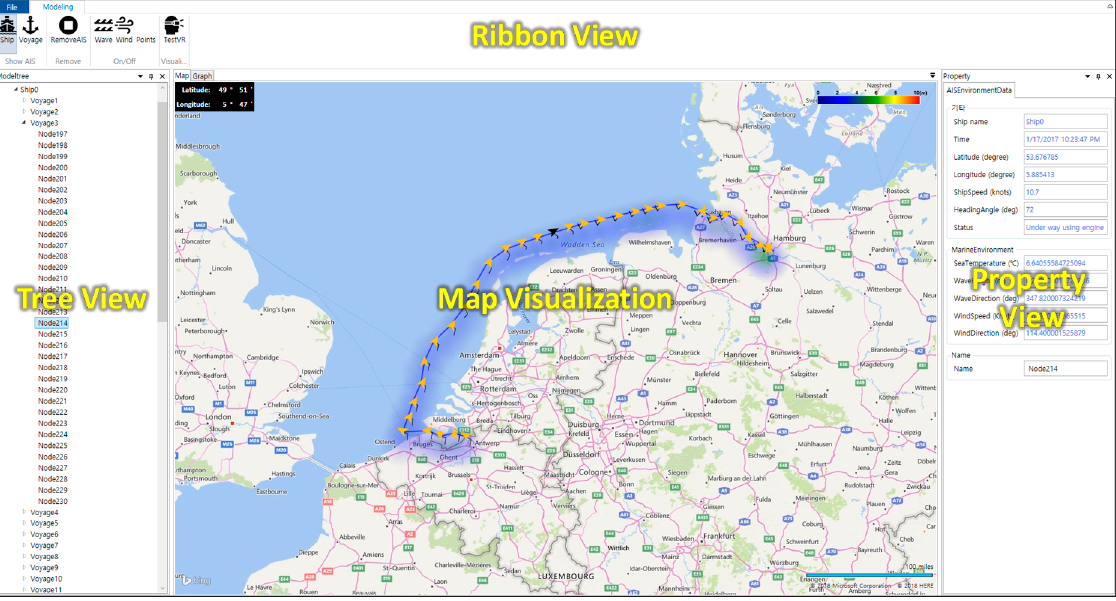
Figure 2. Visualization program.